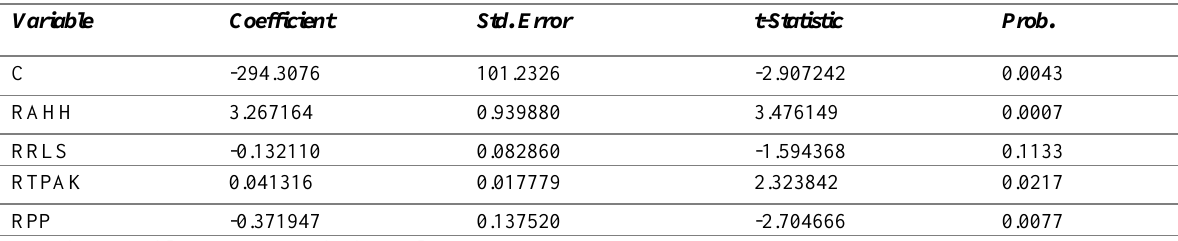
Table 4: FEM Result